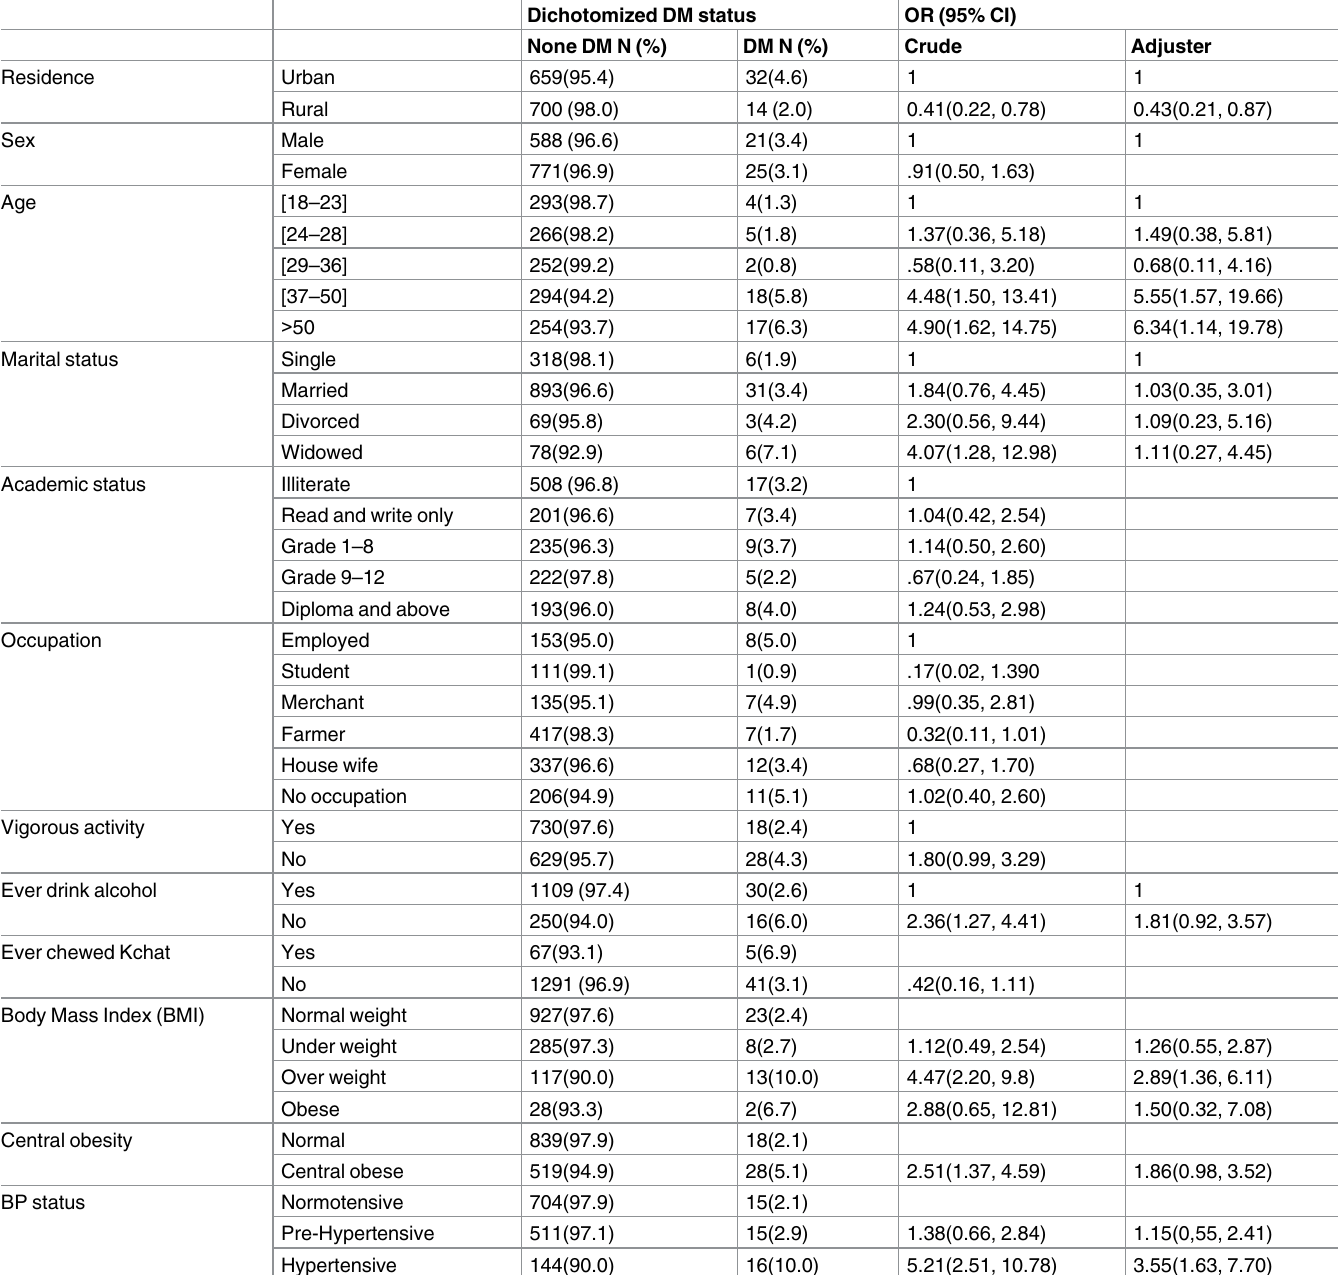
Table 3. Diabetes mellitus and its’ association (N =